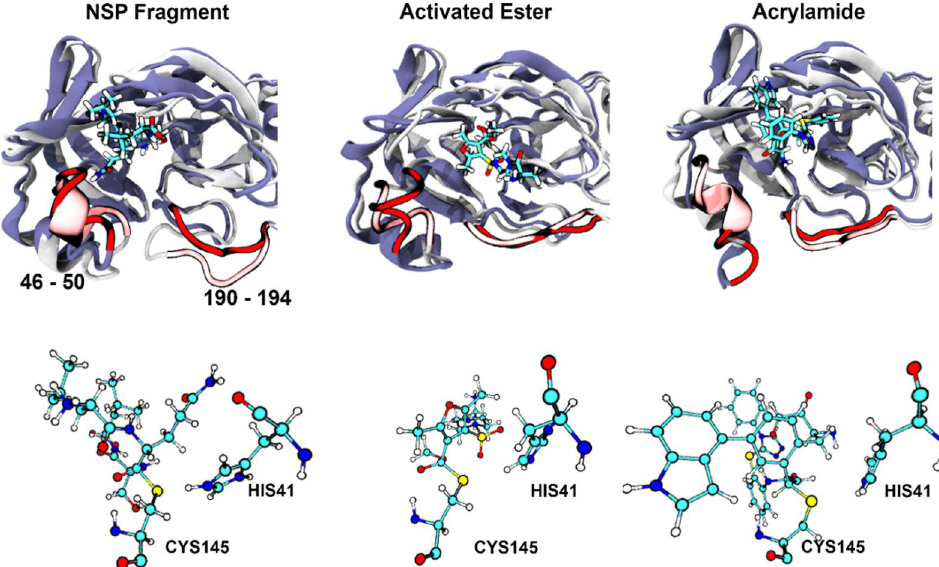
Figure 4. Active site structure of M PRO with and without substrates (NSP, Activated Ester, Acrylamide). Top panels: superimposed images of the ligand-free (white cartoon model) and substrate-bound M PRO active site (light blue cartoon model). Regions with high flexibility in two different states are highlighted as red (ligand- bound state) and light red (ligand-free state). Bottom panels: representative snapshots of the position of the catalytic dyad (HIS41 and CYS145) with respect to the